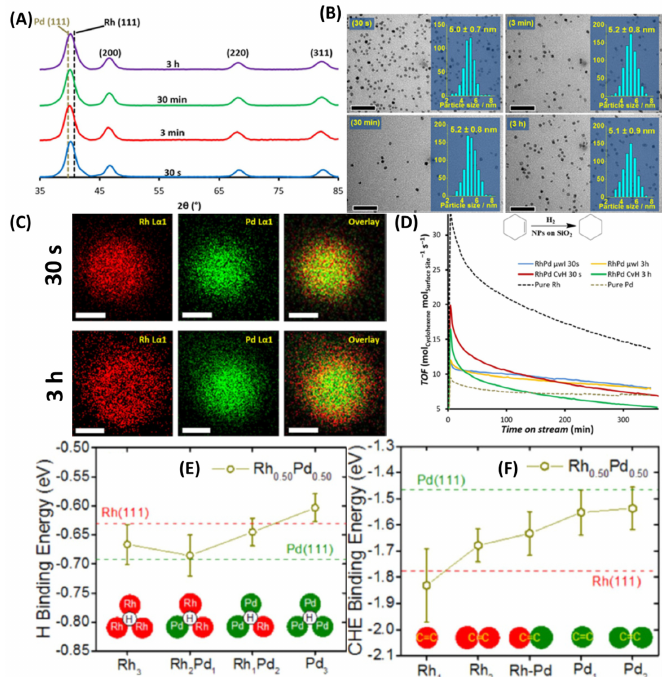
Figure 24. ( A ) PXRD data for Pd 50 Rh 50 alloy NPs synthesized in four different reaction times; ( B ) corresponding TEM analysis; ( C ) EDS data comparisons between 30 s (top panel) and 3 h samples; ( D ) plot of TOF vs. time on stream (min); ( E , F ) respectively show variations in H-, and CHE-binding energies for various binding sites that were considered. Adapted with permission from the